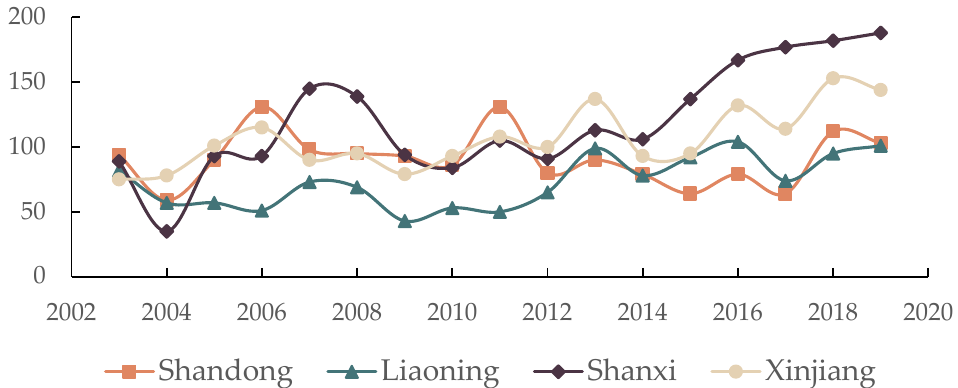
Figure 10. Frequency of environment-related keywords in government work reports over the years.